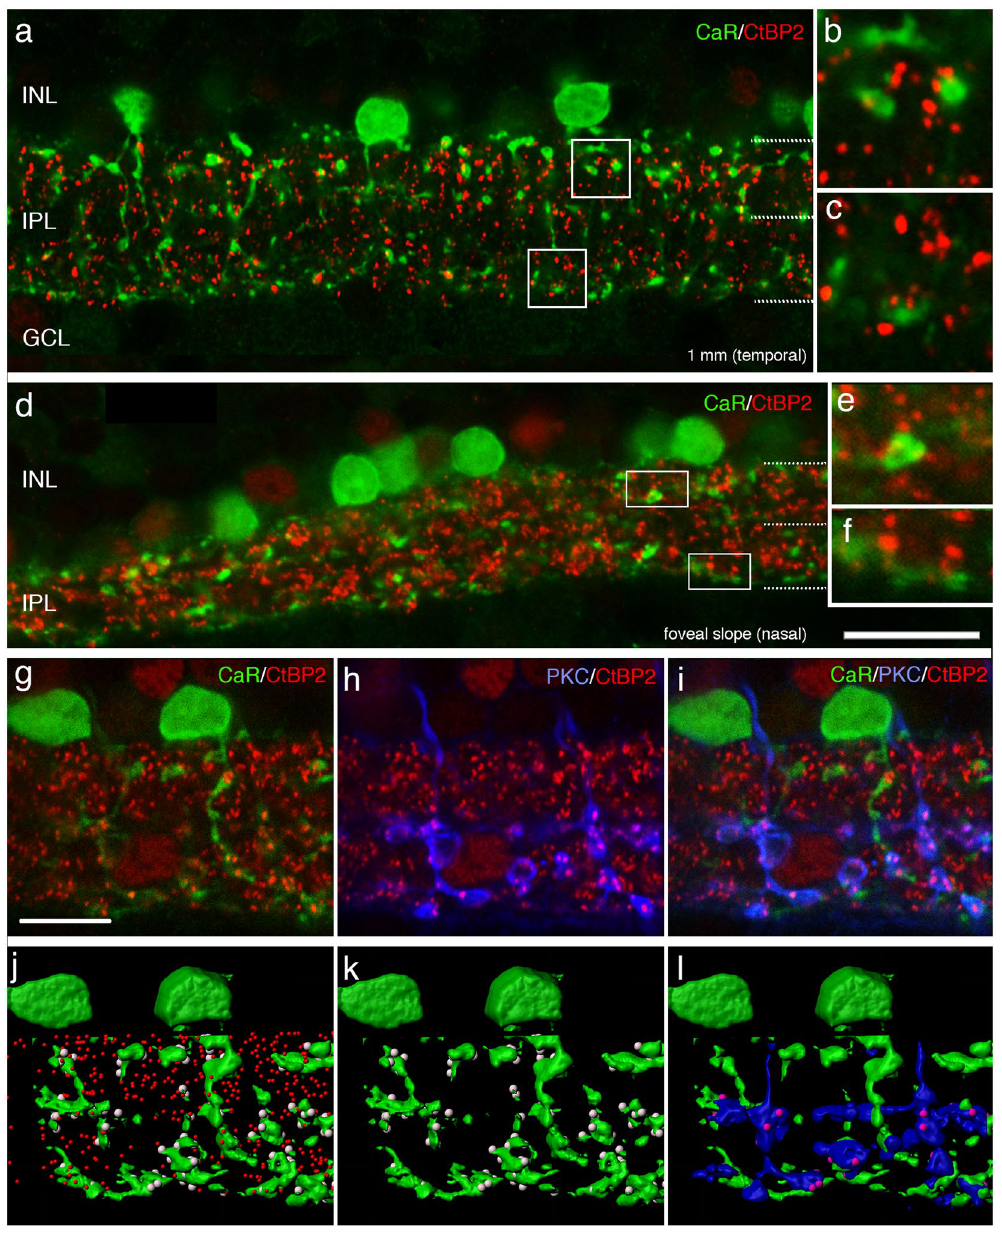
Figure 5. Bipolar connectivity of AII amacrine cells. Confocal images of a vertical vibratome section through macaque retina processed with antibodies against calretinin (CaR, green and the ribbon marker CtBP2, red). ( a ) Central retina, the boxes indicate the regions shown in b and c. Synaptic ribbons are closely associated with the dendrites of AII cells in both the ON and OFF sublamina of the inner plexiform layer. ( d ) Foveal slope, the boxes indicate the regions shown in e and f. ( g–i ) Confocal images of a section that was triple labelled with antibodies against calretinin (green), protein kinase C (blue) and antibodies against CtBP2 (red). ( j–l ) Three dimensional reconstructions of the AII and rod bipolar cells shown in g to i. ( j ) Shows the AII cells together with all synaptic ribbons in that area (red). Synaptic ribbons within 0.3 µ m are shown in grey. ( k ) The same cells as in j together with associated synaptic ribbons; ( l ) the AII cells are shown together with rod bipolar axons (blue) and synaptic ribbons associated with both cell types (magenta). INL, inner nuclear layer; IPL, inner plexiform layer; GCL, ganglion cell layer. Scale bar shown in d = 20 µ m (valid for a and d). Scale bar shown in g = 10 µ m (applies to g to